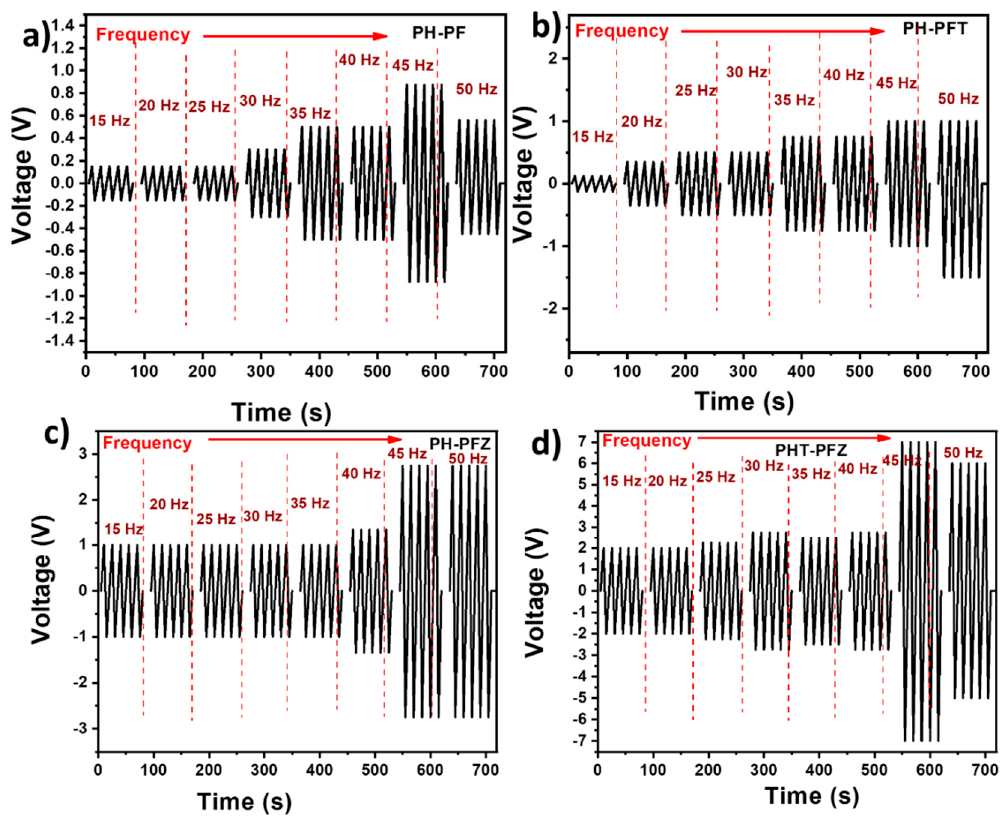
Figure 6. Piezoelectric output voltages for the coaxial electrospun fibers ( a ) PH-PF ( b ) PH-PFT ( c ) PH-PFZ and ( d ) PHT-PFZ.